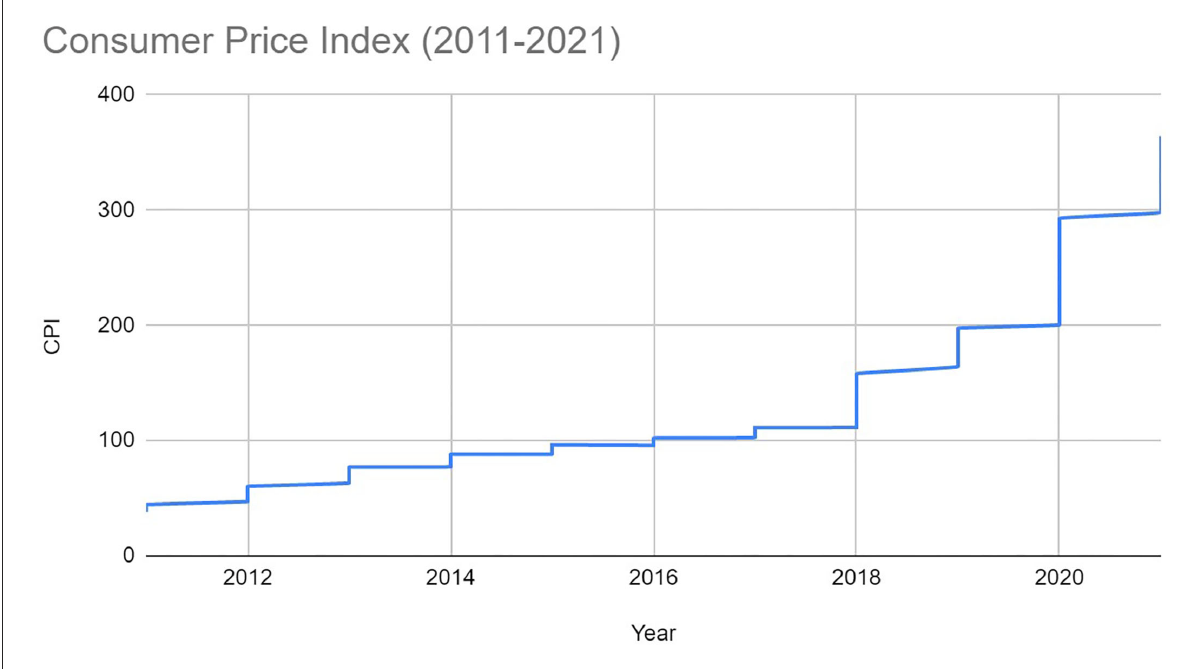
FIGURE6 Monthly CPI in Iran 2011–2021 (Source: www.amar.org.ir).